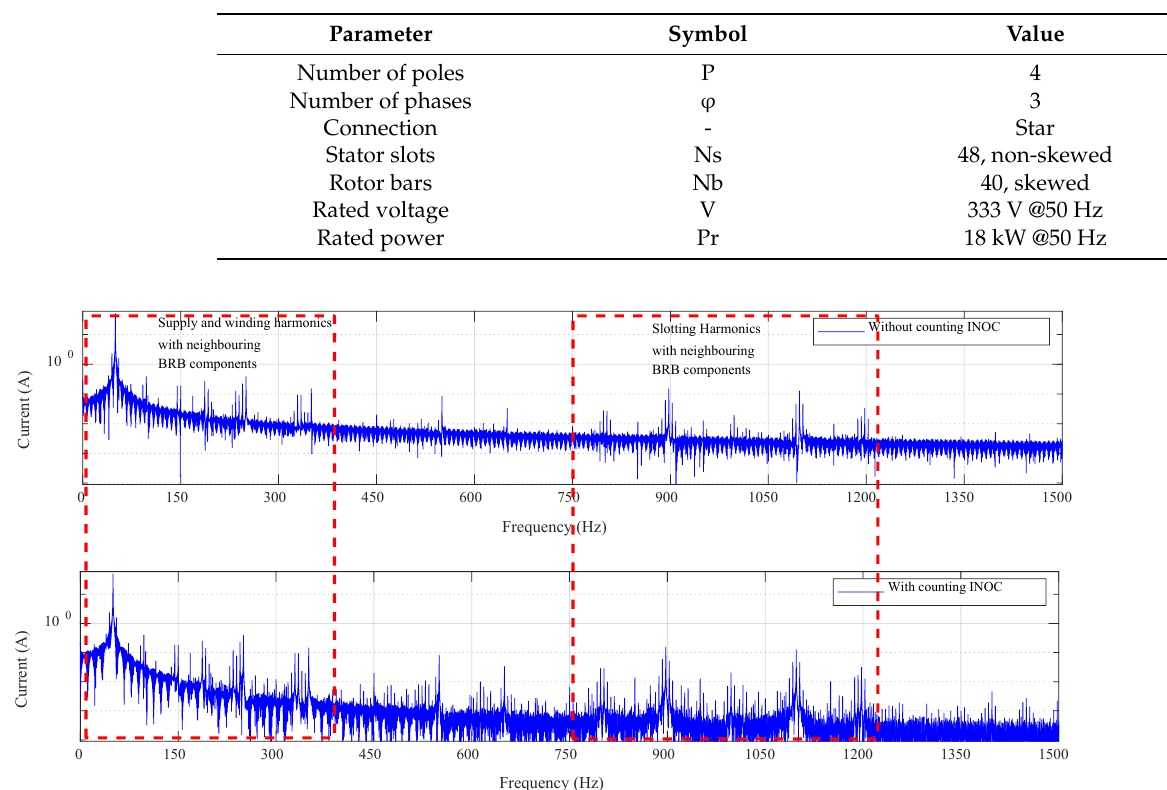
Figure 11. The practical stator current spectrum showing stator winding, slotting, and broken rotor bar-based harmonics before and after counting the integral number of cycles (INOC).